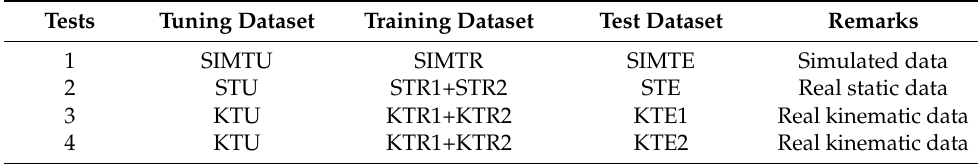
Table 3. List of tests with tuning, training, and test